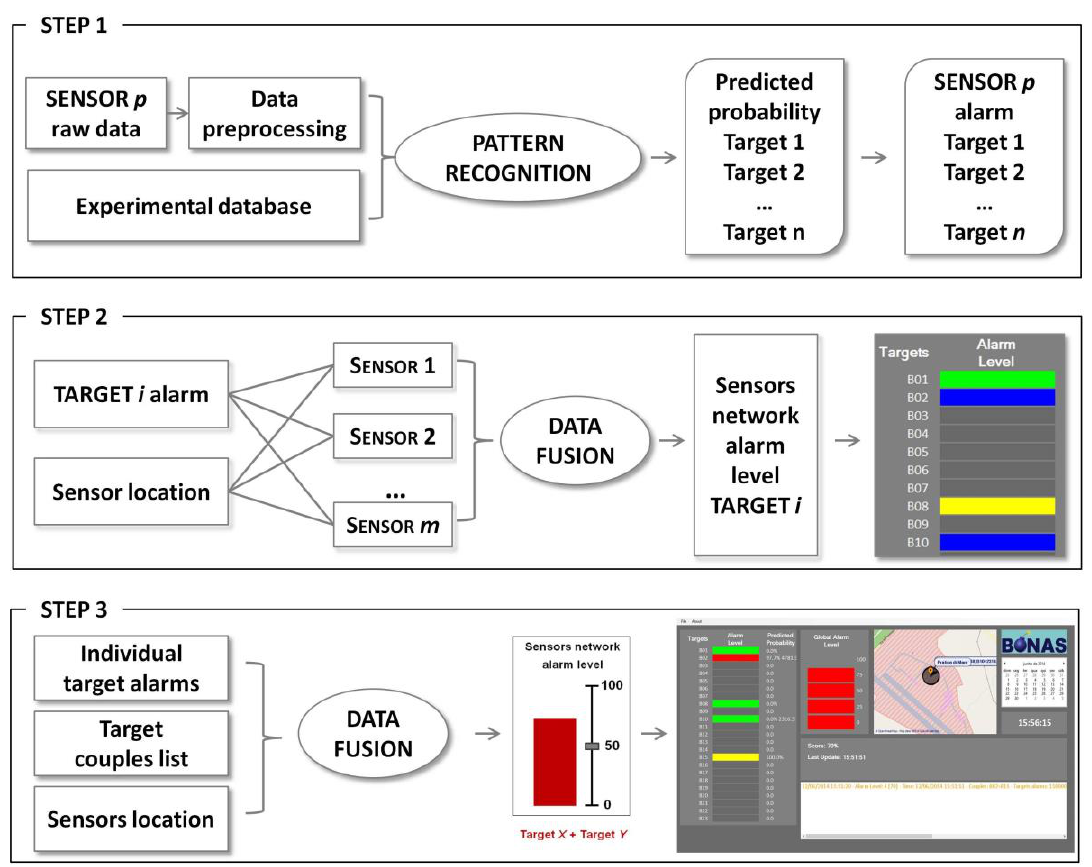
Figure 1. Schematic representation of the three-step approach developed for the BONAS expert system. The alarms due to individual targets are provided as output of Step 2 while the global alarm level is obtained as output of Step 3.